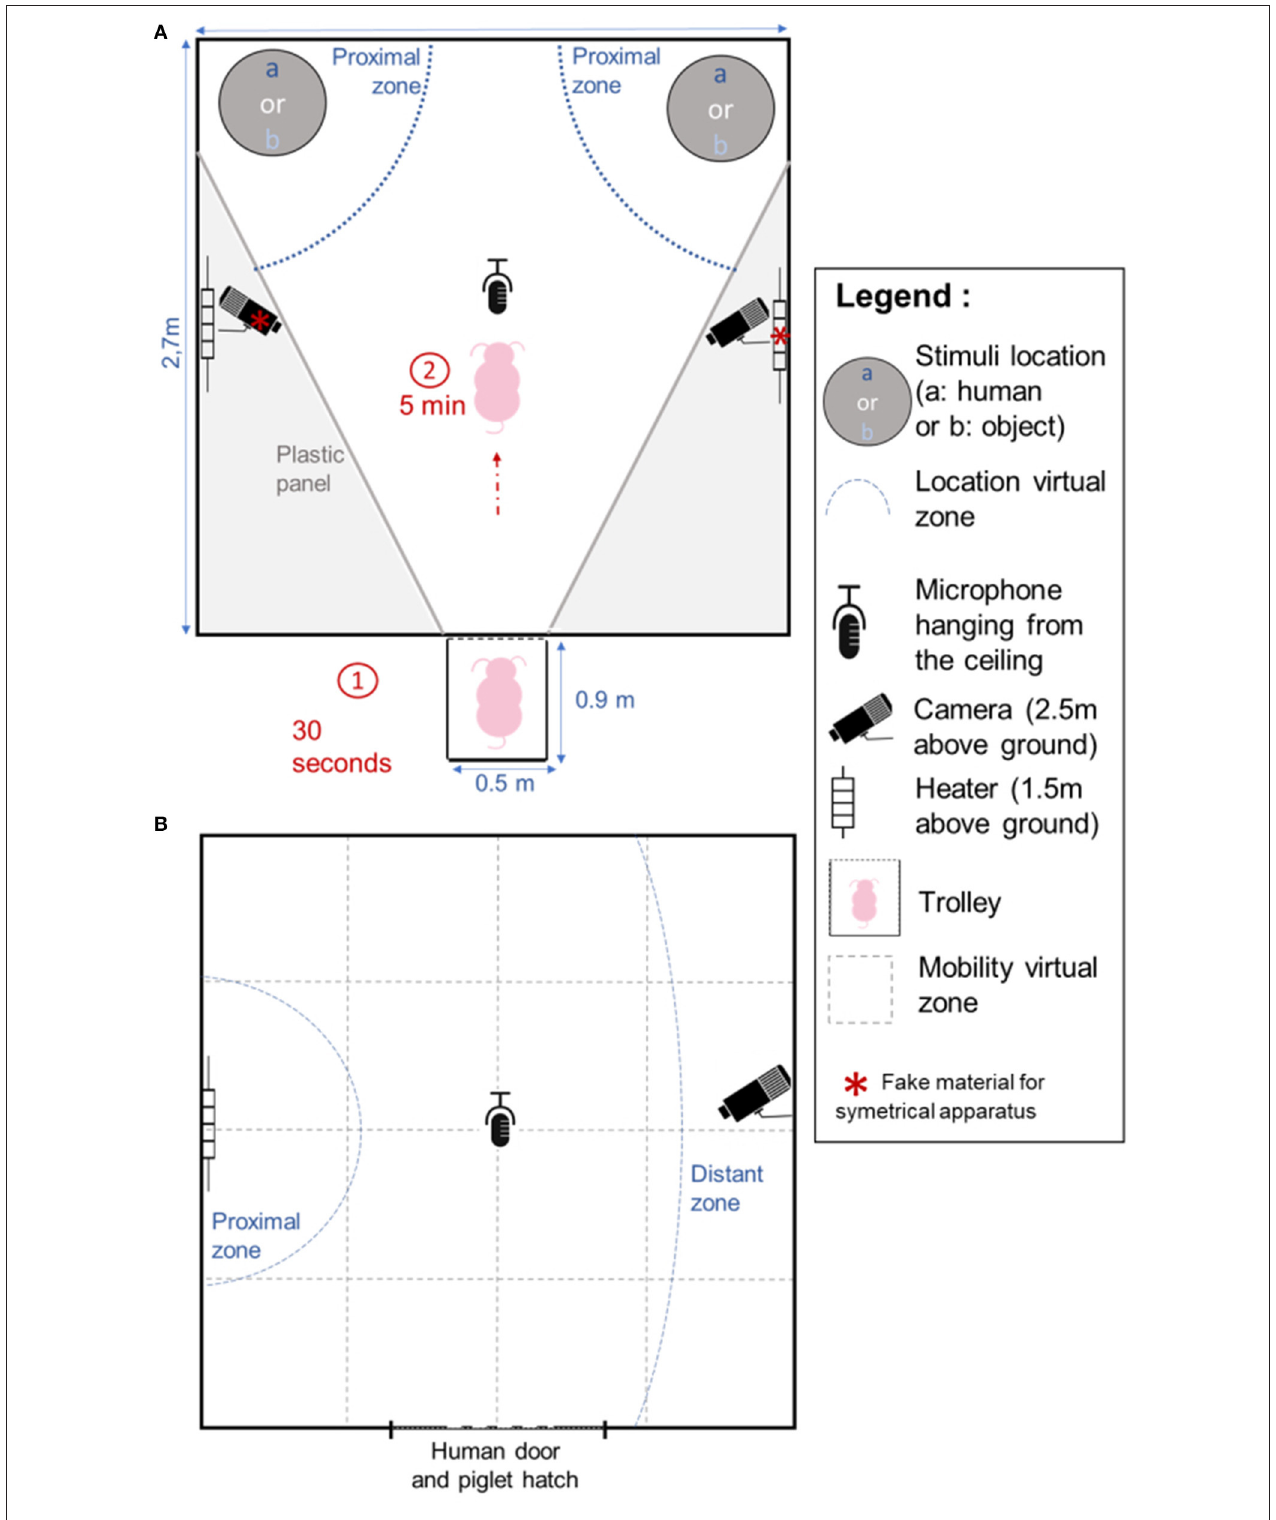
FIGURE 1 | Design of the experimental apparatus for the Choice test (A) and the Isolation/Reunion test (B) . For the Choice test between Object and Human (A) , each pig remained in the trolley for 30s before entering the room where it was left for 5min. For the Isolation/Reunion test (B) , the pig was left alone for 5min (Isolation phase), and then remained for 4min and 30s (Reunion phase) either alone, with the familiar inanimate Object or with the familiar Human, on different days. Proximal zones: blue solid lines were drawn to identify the zones in which the pig was considered close to the stimulus. The distant zone (B) was drawn to identify a zone where the pig was considered distant from the stimulus. Virtual zones were drawn to monitor the location and mobility of the pig in the room (gray dotted lines).